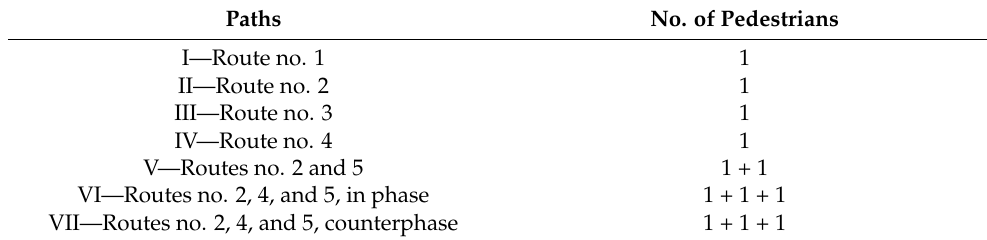
Figure 7. Dynamic simulations: the considered cases and the points (P1–P5) selected along the central alignment to evaluate the induced accelerations. Table 4. The considered paths and pedestrian